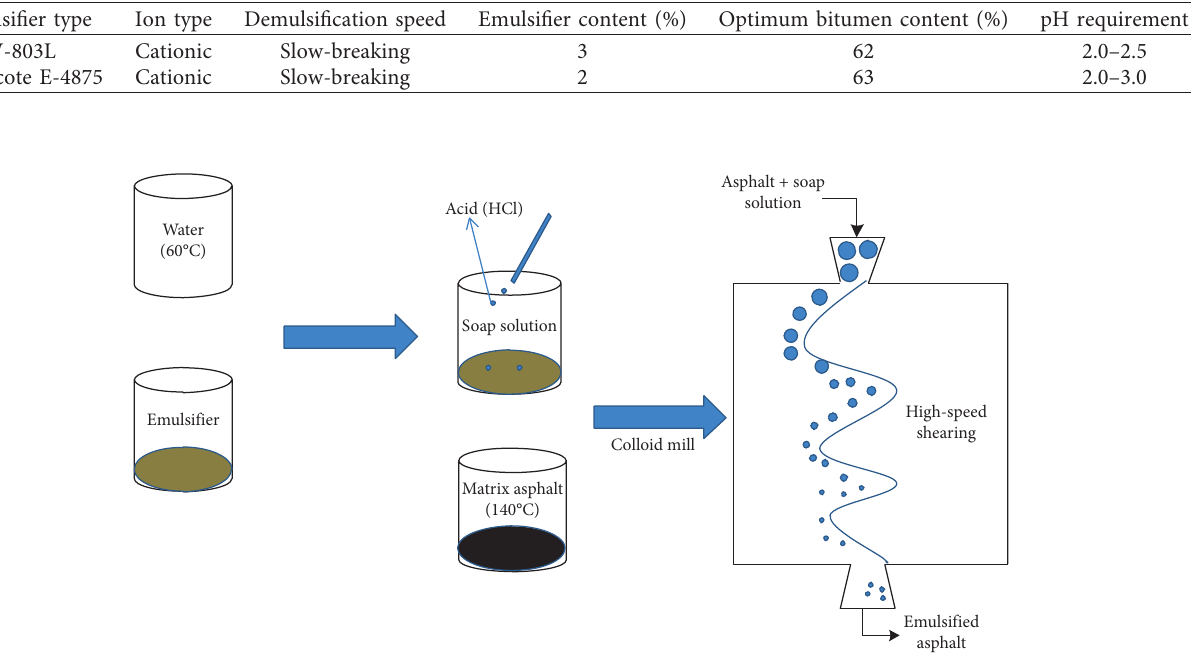
Figure 1: Preparation of the emulsified asphalt.